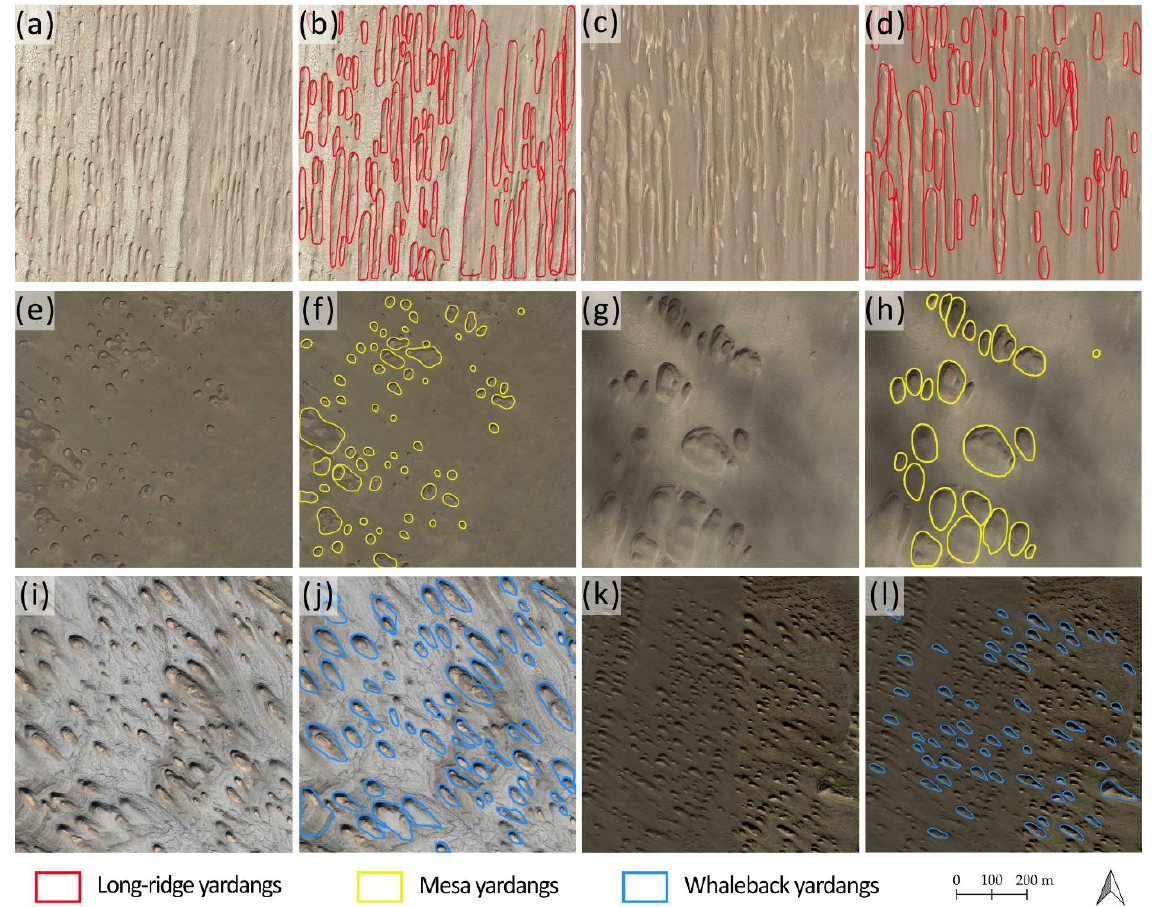
Figure 6. Example delineation and classification results on 1.2 m images. (a,c,e,g,i,k): enlarged 1.2 m spatial resolution images with their locations marked in Figure 2. (b,d,f,h,j,l): corresponding characterization results by Mask R-CNN where long-ridge, mesa and whaleback yardangs are depicted using polygons with red, yellow and blue borders, respectively.